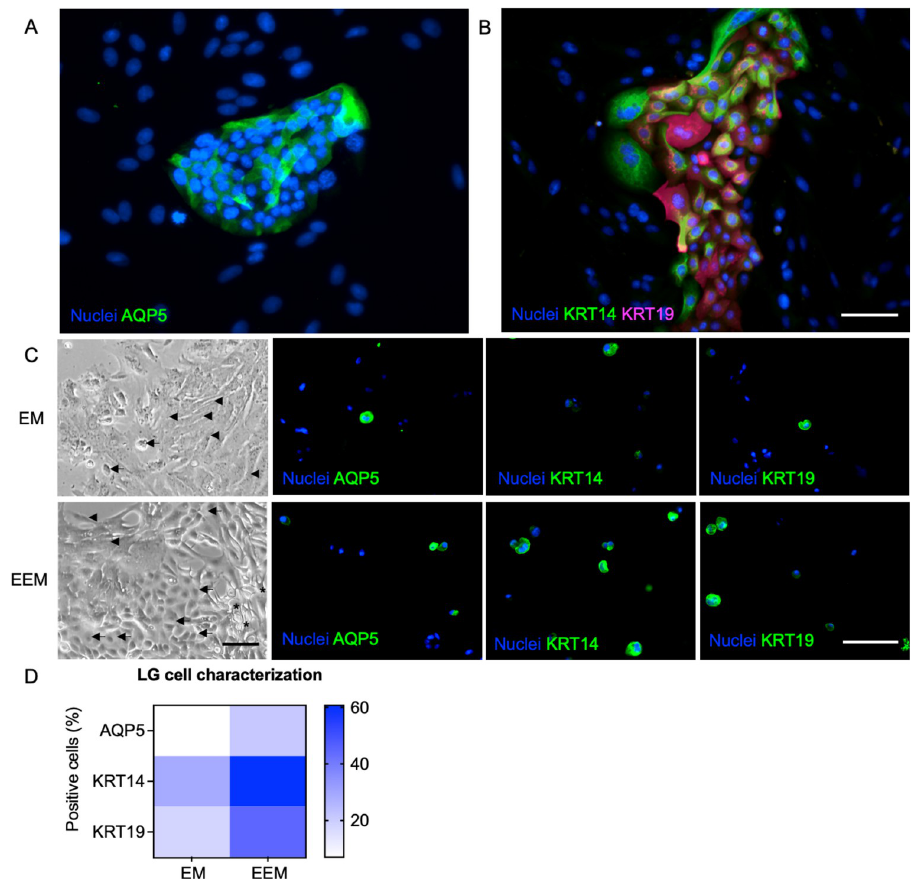
Fig 3. Morphological and proteomic profiling of LG cells in 2D systems. Acinar, ductal and myoepithelial/ductal progenitor compartments of the LG in 2D culture while in expansion media or EM (A). Differentiated cells after 7 days (C) showing numbers of epithelial-like cells (arrow), spindle shape cells (arrowhead) and dendritic cells (asterisk). Scale bar: 200 μ m. AQP5, KRT14, and KRT19 protein markers were profiled and compared in both media conditions (EM versus EEM). Protein markers are quantified and displayed as a heat map with values as average % ± SE.